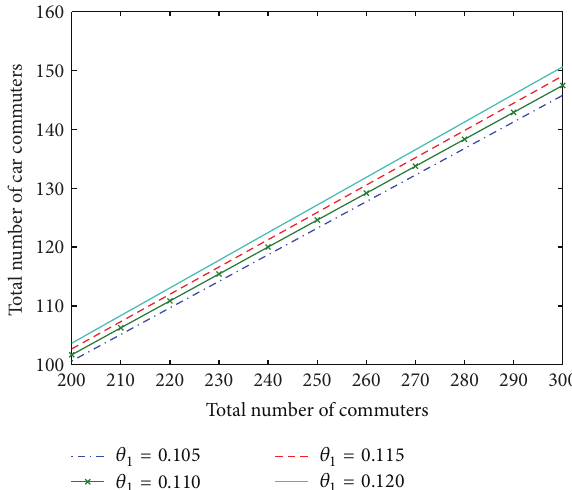
Figure 7: Total social cost versus 𝑁 with different 𝑇 𝑠 .